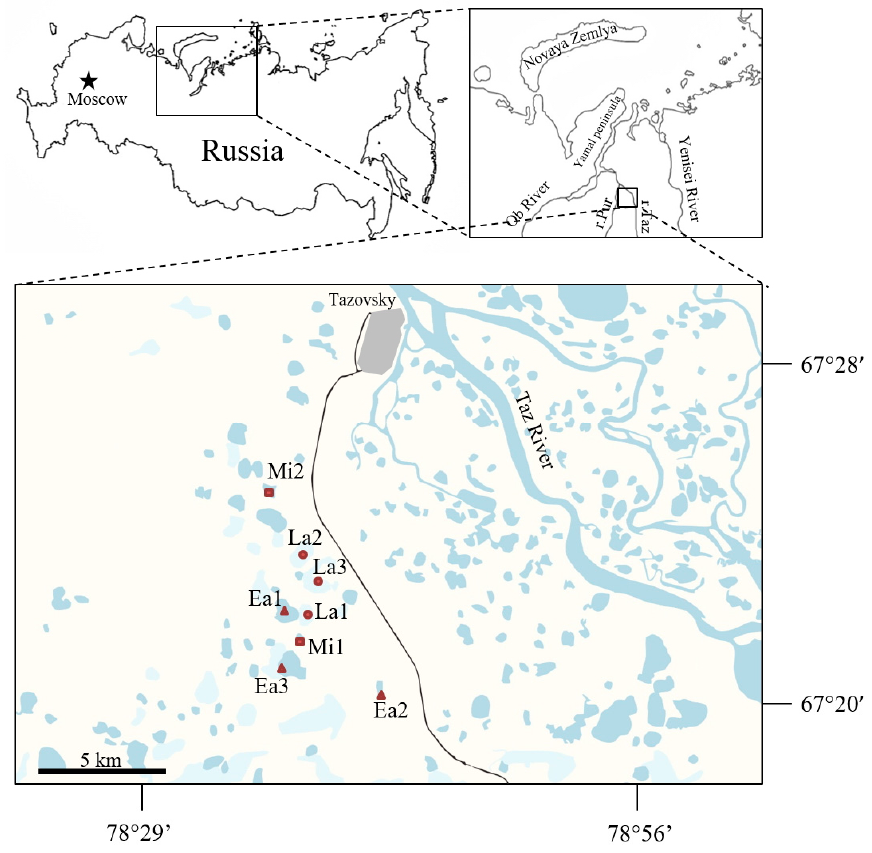
Figure 12. Map of the research area in the northern part of the Pur-Taz interfluve (northern WSL). The studied khasyreys di ff erent stages are shown (Ea—Early, Mi—Mid,